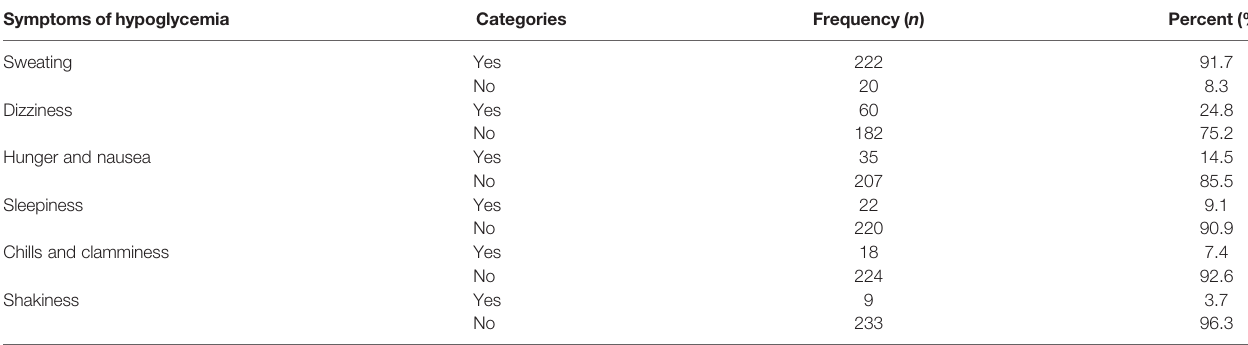
TABLE 3 | Self-reported symptoms of hypoglycemia among type 1 diabetes patients at metu karl heinz referral hospital in ethiopia. Symptoms of hypoglycemia